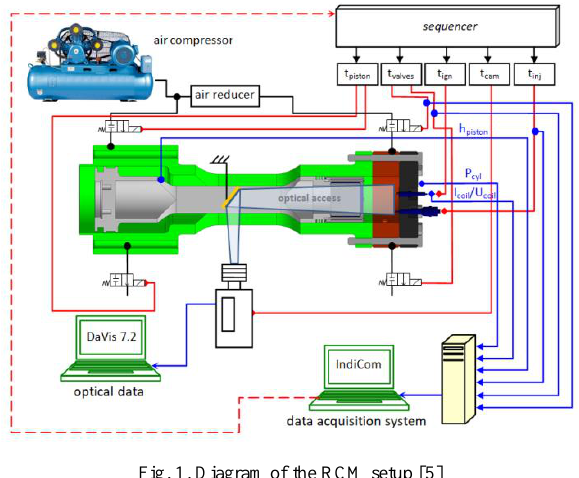
Fig. 1. Diagram of the RCM setup [5] Table 1. Characteristics of a rapid compression machine Parameter